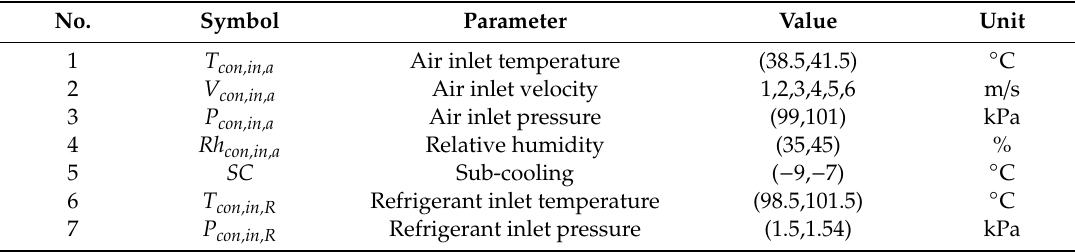
Table 7. Experimental conditions of